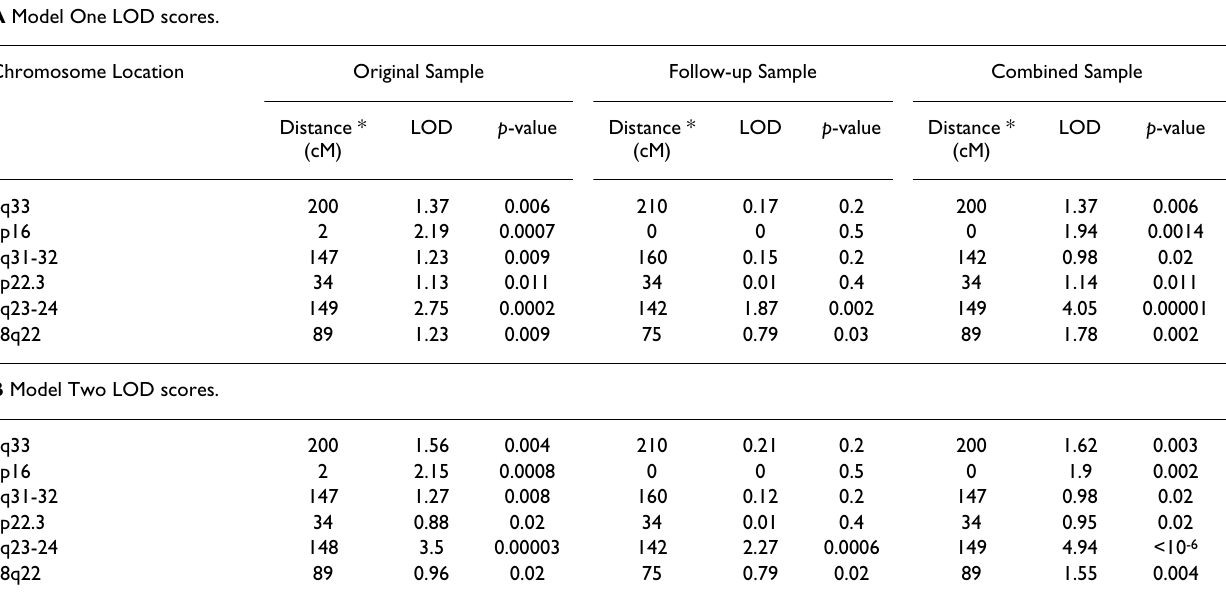
Table 3: Multipoint LOD score and chromosomal location in the Original, Follow-up and Combined samples are shown. A Model One LOD